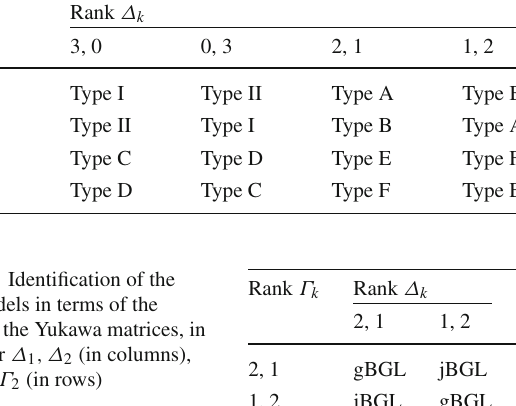
ranks of the Yukawa matrices, in the order Δ 1 ,Δ 2 (in columns), and Γ 1 ,Γ 2 (in